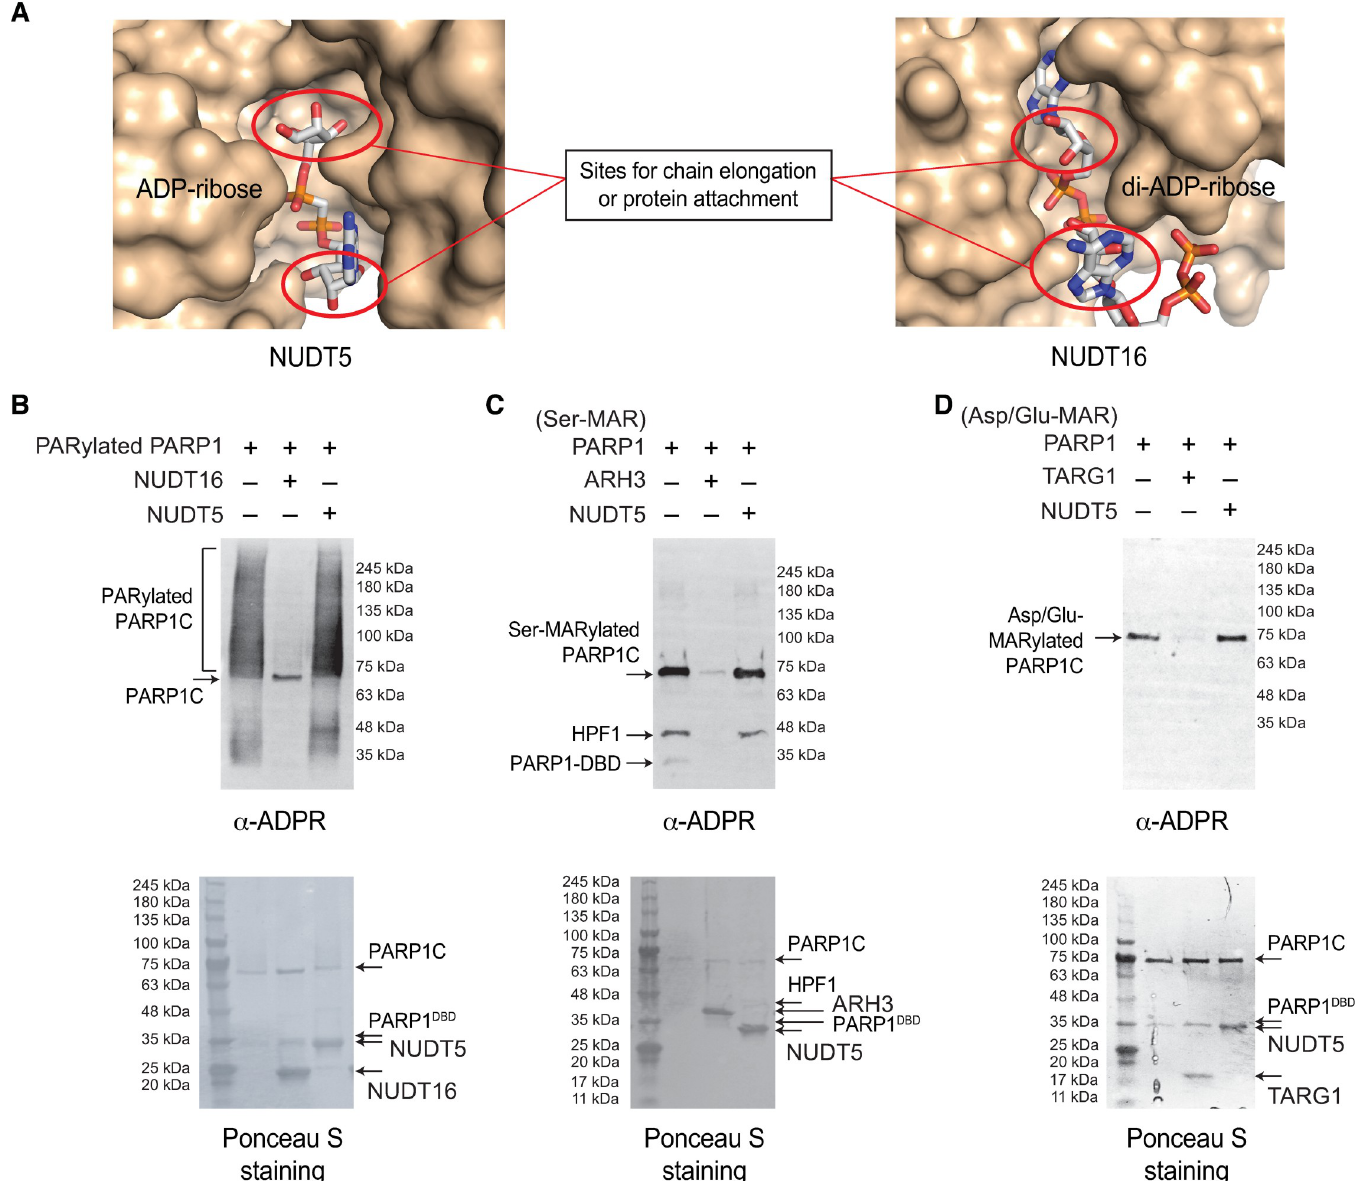
Fig 2. NUDT5 selectively cleaves protein-free ADP-ribose, but not protein-bound poly- and mono-ADP-ribosylations. A. NUDT5 is unable to bind to the protein- bound mono-ADP-ribosylation or poly(ADP-ribose). The sites for chain elongation or protein attachment are blocked in NUDT5 but are open in NUDT16. The substrate-binding pocket for NUDT5 and NUDT16 are superimposed and the orientations of ADP-ribose binding are shown. B. NUDT5 is unable to cleave the protein- bound PARylation. PARylated PARP1 was treated with recombinant human NUDT5 (5 μ M) and NUDT16 (5 μ M). While NUDT16 efficiently reverses the protein- bound PARylation, NUDT5 shows little-to-no PAR hydrolysis activity. C-D. NUDT5 is unable to cleave the protein-bound mono-ADP-ribosylations. Ser- and Asp/Glu- MARylated PARP1 substrates (see the “Materials and Methods”) were digested with 5 μ M of each human ARH3 and NUDT5 (in panel C) and TARG1 and NUDT5 (in panel D), respectively. NUDT5 shows little-to-no MAR hydrolase activity, whereas ARH3 and TARG1 effectively reverse Ser- and Asp/Glu-MARylated PARP1 substrates,